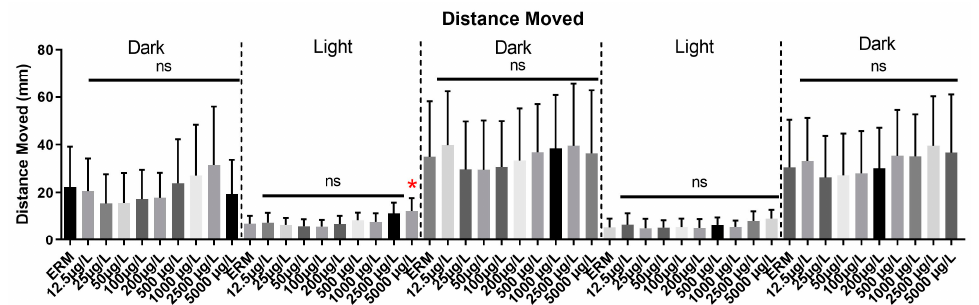
Figure 7. Visual Motor Response Test (VMR) for zebrafish larvae exposed to ERM (control), 12.5, 25, 50, 100, 200, 500, 1000, 2500, and 5000 µg/L concentrations of sulfamethoxazole at 7 dpf. Each light and dark cycle shows a 10-min interval. Data from eight independent trials are merged as a single graph. One-way ANOVA followed by Holm’Š í d á k’s multiple comparisons test, ns = non-significant, * p ≤ 0.05, n = 17–32 larvae per